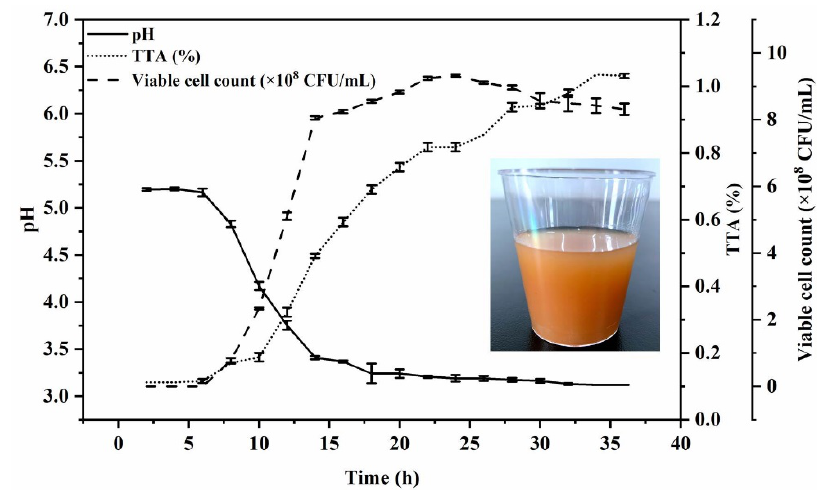
Figure 2. Changes in viable cell counts, pH values, and TTA values during fermentation of the R–B mixed juice with L. plantarum TUST-232, and the picture of the beverage produced under the selected fermentation conditions. The growth curve was determined under the selected conditions of 0.3% inoculation volume and fermentation at 37 °C for 36 h.